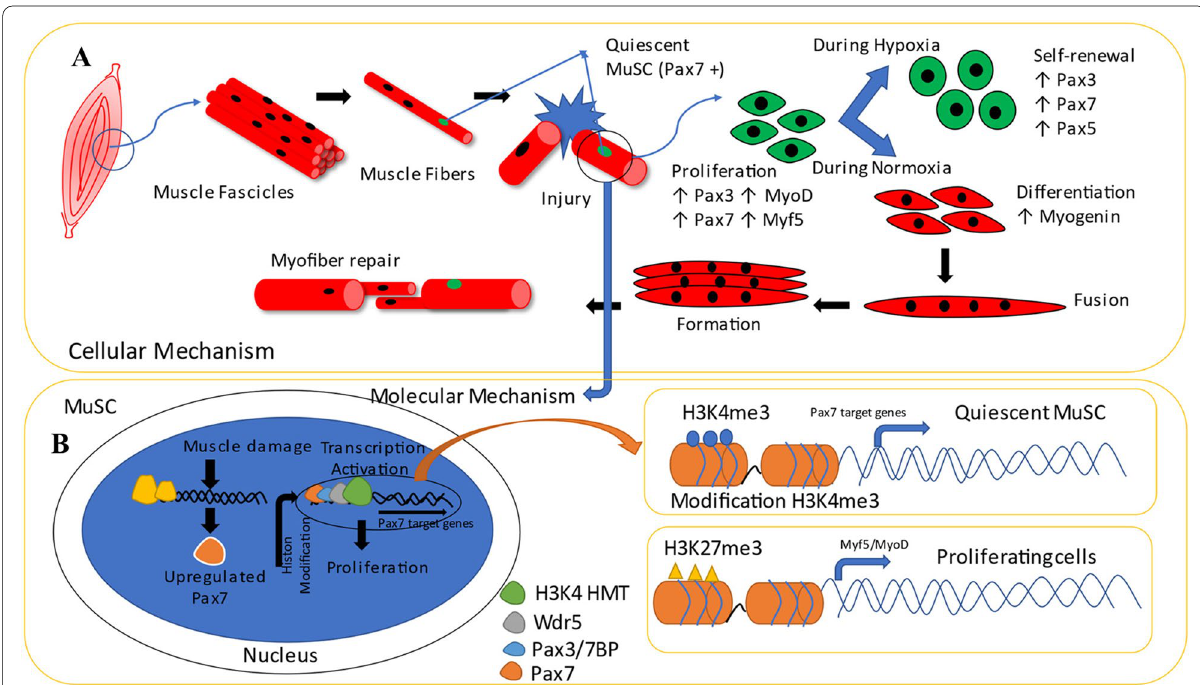
Fig. 2 The mechanism of action of Pax3/Pax7 for skeletal muscle stem cells is divided into two mechanisms; cellular and molecular mechanisms. A Cellularly, the mechanism consists of six stages: (1) muscle damage, (2) proliferation, (3) differentiation, (4) fusion, (5) formation, and (6) myofibre repair. B Molecularly, the mechanism is divided into several stages: (1) histone modification and (2) proliferation activation against the recruitment of a histone methyltransferase complex